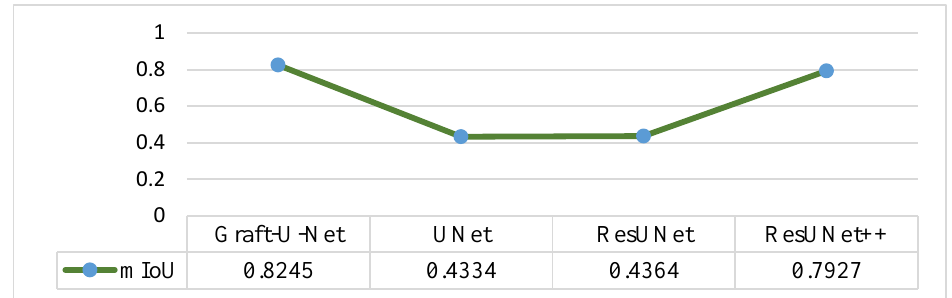
Figure 8. Comparison of Graft-U-Net on Kvasir-SEG dataset in terms of mIoU. The results of Graft-U-Net (0.9433) in terms of Recall are compared with the pre-study models of UNet (0.6306), ResUNet (0.5041), and ResUNet++ (0.7064). The outcome shows that recall is enhanced when using the Kvasir-SEG dataset. The outcome of the recall is illustrated in the form of a table and a graph in Figure 9.